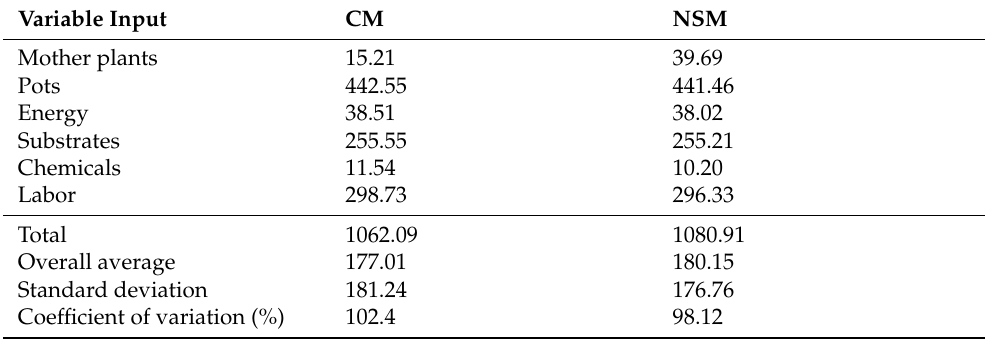
Table 16. Average variable input production costs (EUR/by cycle of 1000 plants)) variation associated with two production models: conventional production model (CM) and novel and sustainable production model (NSM), among 8 selected ornamental species. (Average is based on market prices. Year: